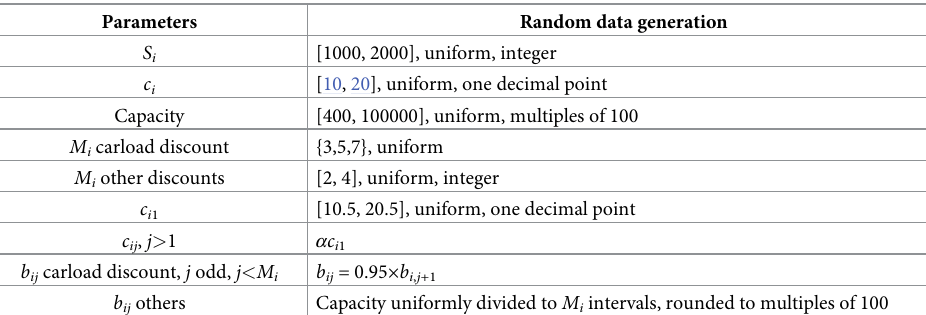
Table 6. Random data